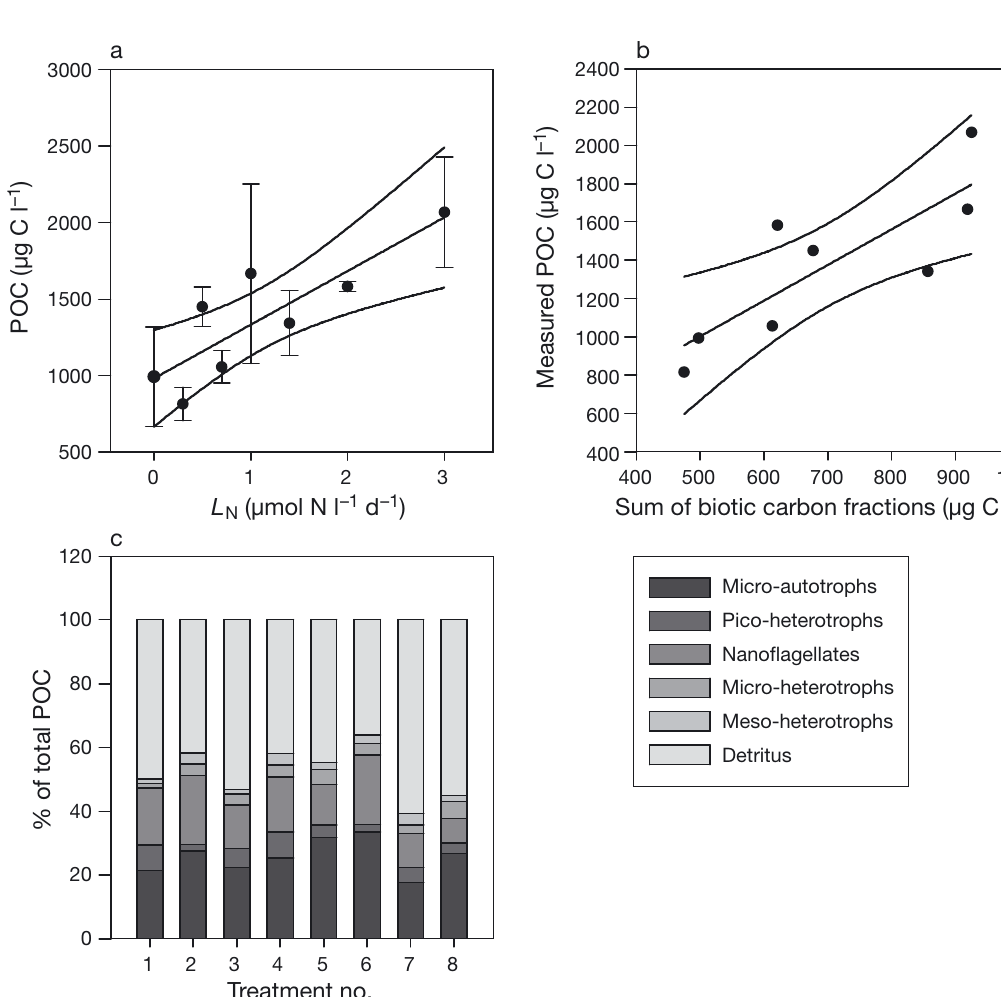
Fig. 4. (a) Average (n = 3) particulate organic carbon (POC, µg C l −1 ) as a function of nutrient loading rate ( L N , µmol NH 4 l −1 d −1 ) at the final sampling (Day 16), with a positive linear relationship with nutrient loading rate (R 2 = 0.72, p = 0.012). The linear regression line is shown with 95% confidence intervals and bars denoting ± 1 SE. (b) POC plotted against total biotic carbon calculated as the sum of the estimated carbon biomass of the organism fractions, with linear regression line with 95% confi- dence lines: (measured POC) = 1.86 × (estimated POC) − 68.88, R 2 = 0.68, p = 0.012. (c) Percent composition of the functional plankton groups on Day 16 (see Table 1 for details on